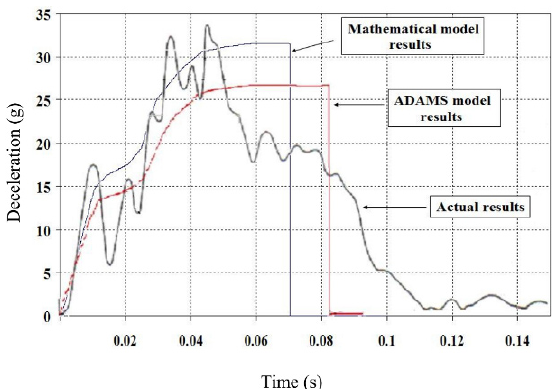
Figure 8. Velocity of the vehicle body.